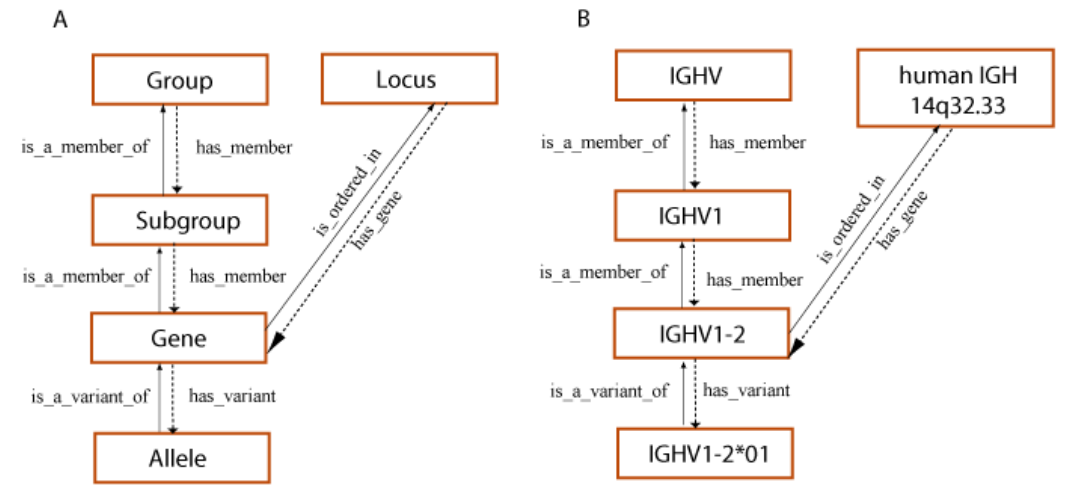
Figure 13. Concepts of classification for IMGT gene and allele nomenclature (CLASSIFICATION axiom) [37,38]. ( A ) Hierarchy of the concepts of classification and their relations. The definition of the reciprocal relations between concepts can be read, from one concept to the other, either ascending the hierarchy (solid arrows) or descending the hierarchy (dotted arrows). ( B ) Examples of concept instances for each concept of classification. The concept instances are associated to an instance of the “Taxon” concept, and more precisely for the “Gene” and “Allele” concepts to an instance of the “Species” concept (here, Homo sapiens ) [1–5,37,38,84,85]. The “Locus” concept is a concept of localization (LOCALIZATION axiom) [28]. It is shown with the reciprocal relations to the “Gene” concept. (With permission from M-P. Lefranc and G. Lefranc, LIGM, Founders and Authors of IMGT ® , the international ImMunoGeneTics information system ® , http://www.imgt.org).